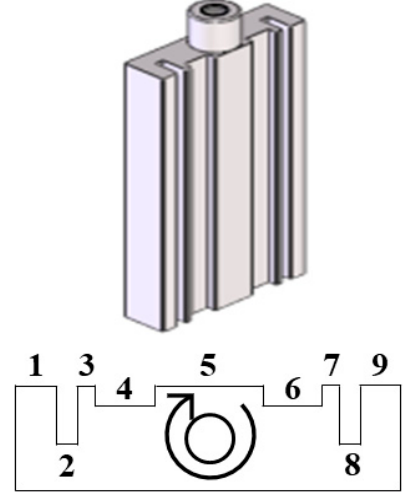
Figure 1. Corrugated specimen as a rotating cathode.